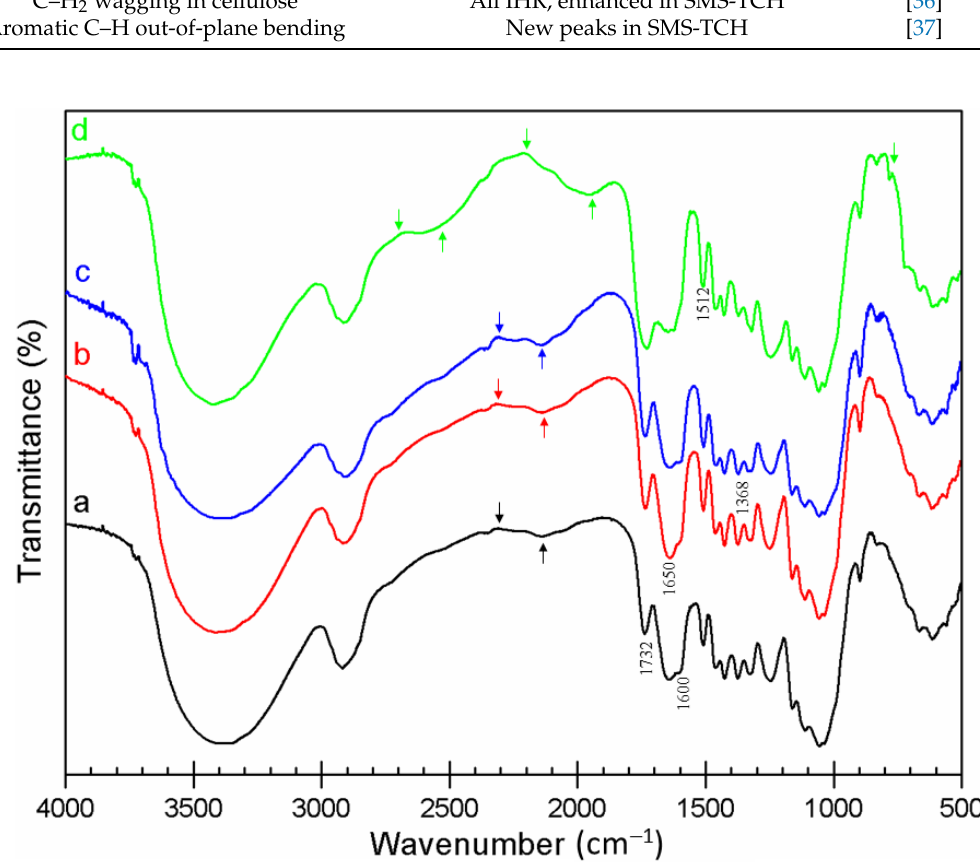
Figure 4. FTIR spectra of ( a ) raw and pretreated ( b ) AH, ( c ) TH, and ( d ) TCH solid residues of IHR. Arrows show peak variations with respect to the other